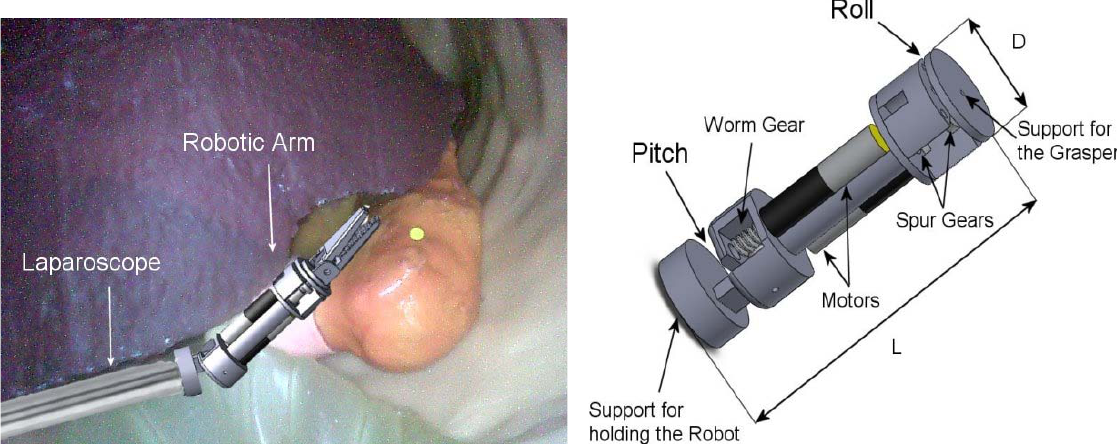
Figure 1. (a) View of the robot in a possible working scenario in a phantom with silicone organs (provided by EndoCAS Center, Pisa, Italy); the grasper will be substituted by the compliant grasper of Fig. 2; (b) 3-D sketch of the